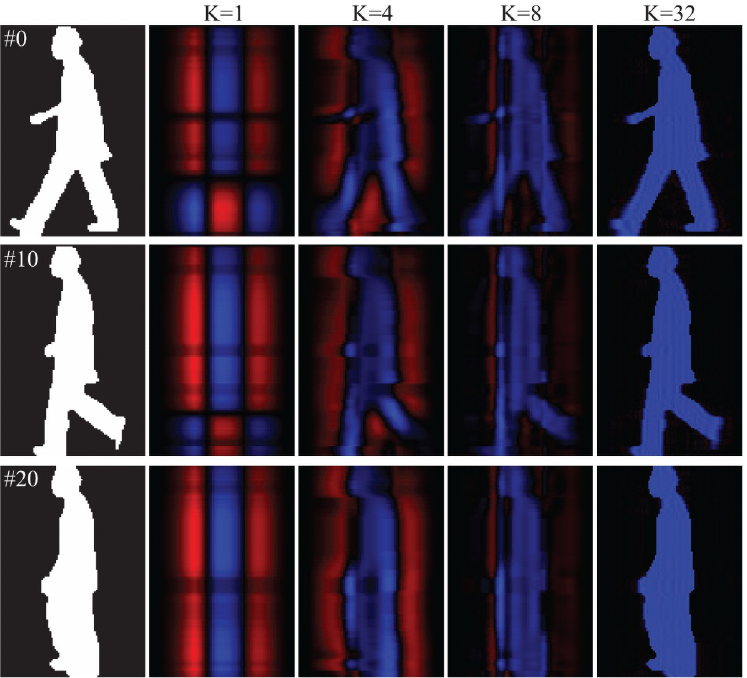
Fig 7. Examples of reconstructed images with K = 1, 4, 8, 32 by 2D PCA. Blue and red colors min positive and negative values.